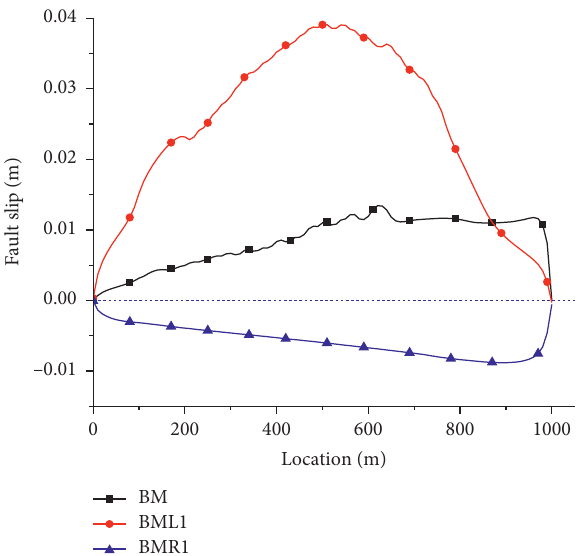
Figure 15: Fault slip along the fault plane when the fracturing region was BM, BML1, or BMR1.